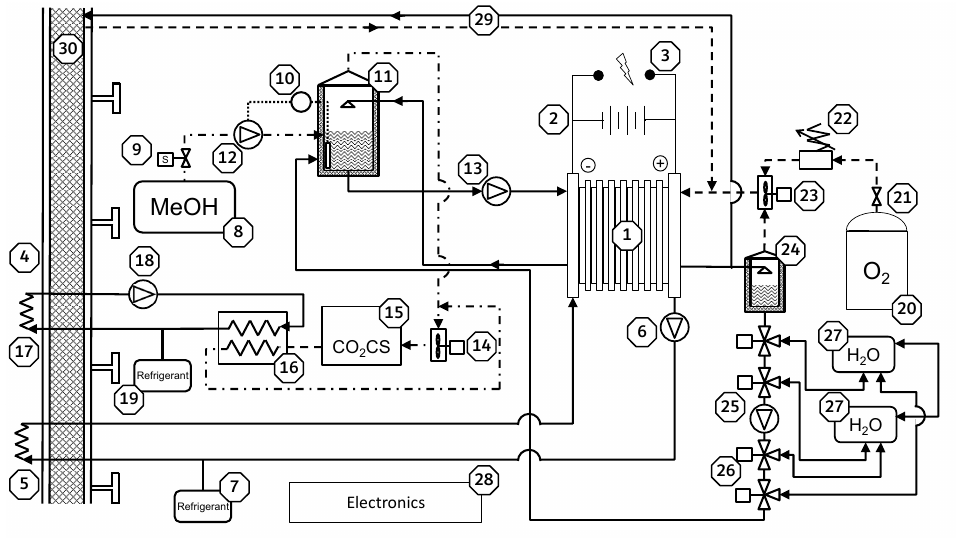
(cid:13) (cid:13) (cid:13) (cid:13) Figure 5. Sketch of the power plant. 1 Fuel cell stack. 2 Batteries. 3 Power bus. 4 Sea water. (cid:13) (cid:13) (cid:13) 5 Stack cooling heat exchanger. 6 Stack cooling pump. 7 Stack cooling loop. Coolant reservoir. (cid:13) (cid:13) (cid:13) (cid:13) 8 MeOH tank. 9 MeOH tank isolation valve. 10 MeOH concentration sensor. 11 MeOH (cid:13) (cid:13) (cid:13) reservoir and CO 2 separation tank. 12 MeOH feeding pump. 13 Anode circulation pump. 14 (cid:13) (cid:13) (cid:13) CO 2 CS circulation blower. 15 CO 2 Capture System (CO 2 CS). 16 CO 2 CS heat exchanger. 17 CO 2 CS (cid:13) (cid:13) (cid:13) cooling heat exchanger. 18 CO 2 CS cooling pump. 19 CO 2 CS cooling loop. Coolant reservoir. 20 O 2 (cid:13) (cid:13) (cid:13) cylinder. 21 O 2 pressure reduction valve. 22 O 2 low flow electronic pressure regulator. 23 Cathode (cid:13) (cid:13) circulation blower. 24 Cathode separation tank. 25 Multipurpose pump. Anode refilling pump and (cid:13) (cid:13) (cid:13) trimming system pump. 26 3-way valves. 27 Trimming tanks (bow and stern). 28 Electronic control (cid:13) (cid:13) and management system. 29 Purge circuit. 30 Syntactic